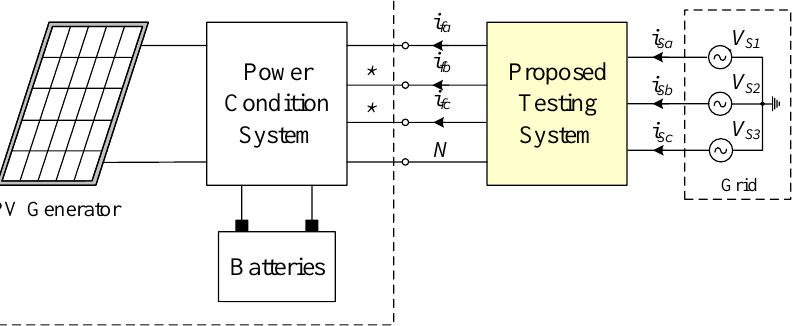
Figure 1. Simplified block diagram of the overall system (single phase without *phases or three-phase with *phases).